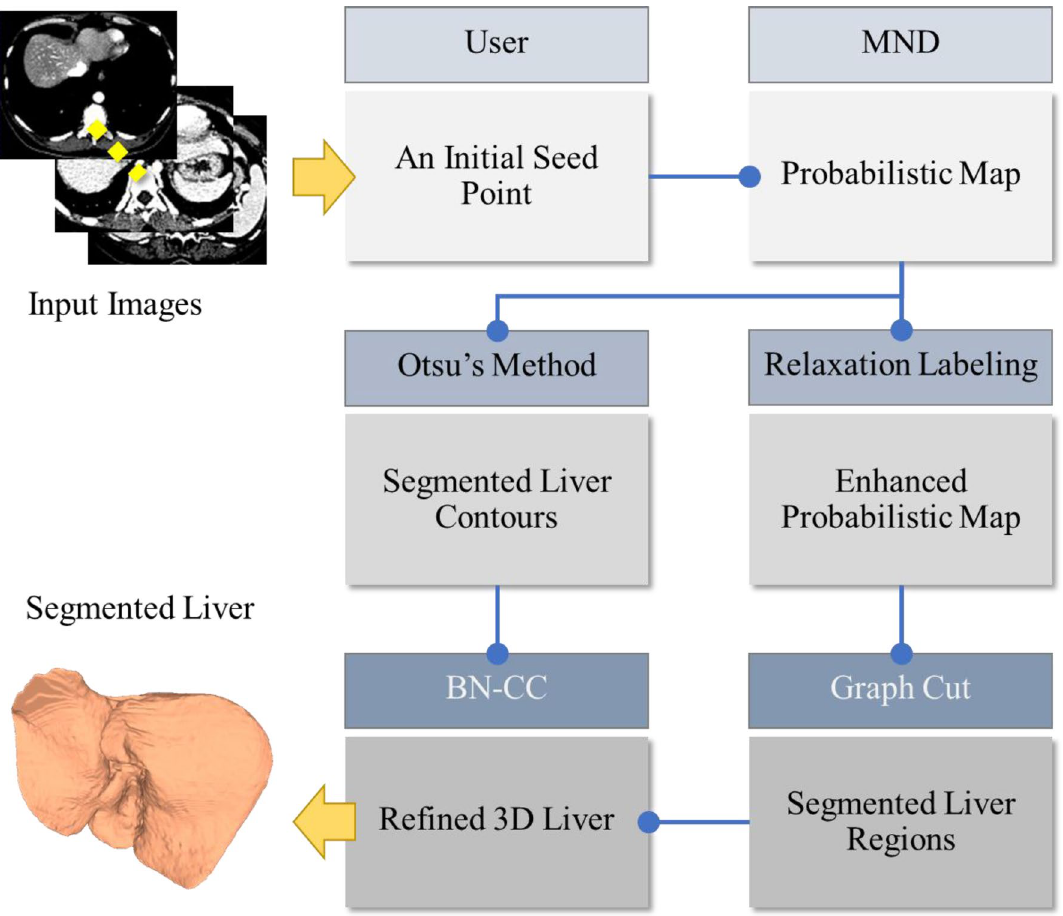
Figure 2. Diagram of the proposed scheme. Herein, MND and BN-CC stands for multivariate normal distribution and bottleneck detection and contour constraint,